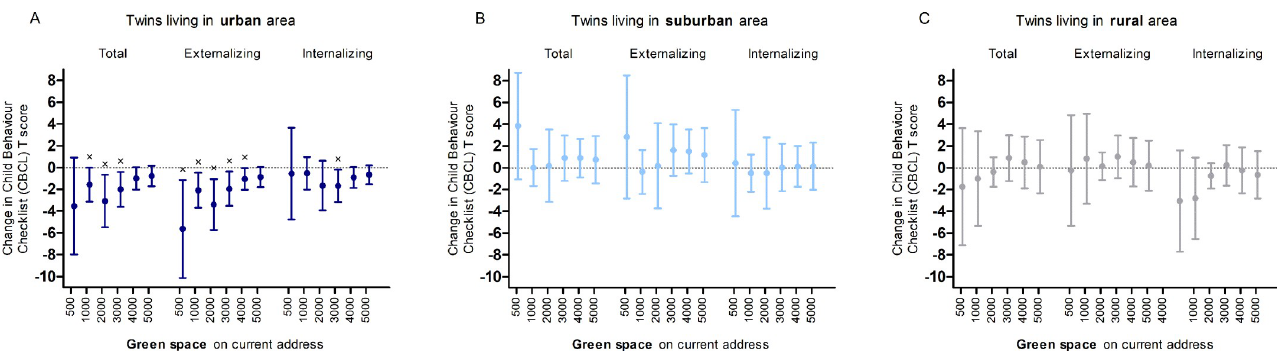
Fig 4. Estimated change in CBCL score for an IQR increase in green space in a 500–5,000-m radius around the residence. In twins living in (A) an urban ( n = 168), (B) a suburban ( n = 92), and (C) a rural area ( n = 182). Adjusted for sex, age, parental education, neighborhood household income, month of CBCL, and zygosity and chorionicity. We expressed the estimates for an IQR change in percentage green space for buffers from 1,000 to 5,000 m. Because of the skewedness of the data for the 500-m radius (and 1,000 m in rural), we expressed the effect size for a dichotomized variable representing the presence or absence of green space within this buffer. CBCL, Child Behavior Checklist; IQR, interquartile range.